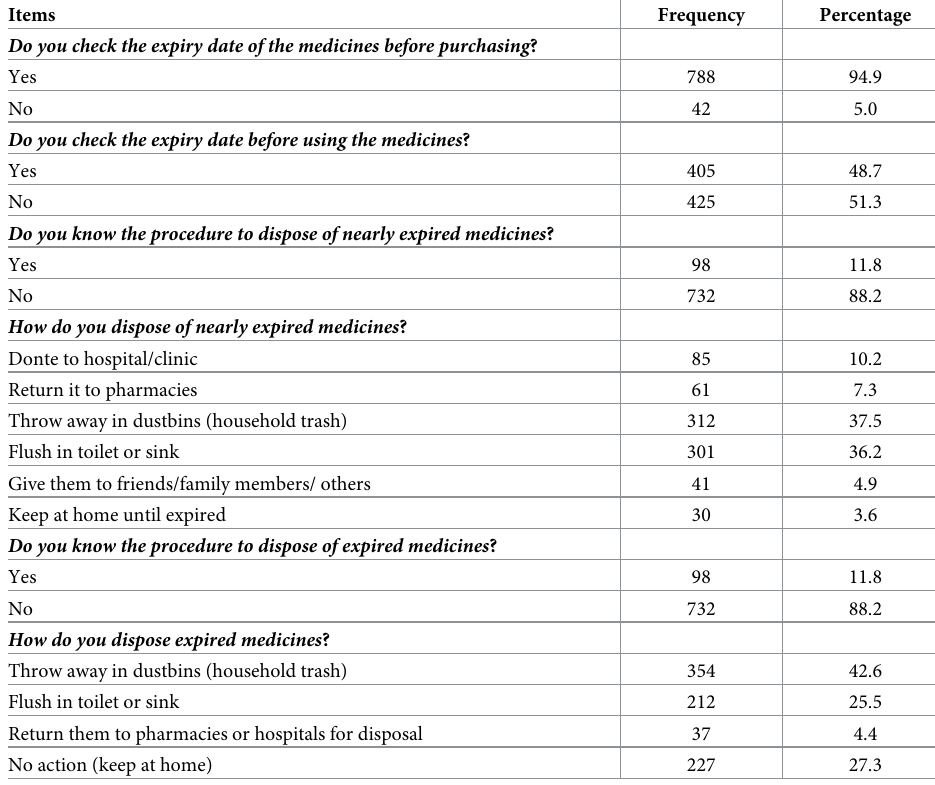
Table 3. Practices and disposal of expired medicines.